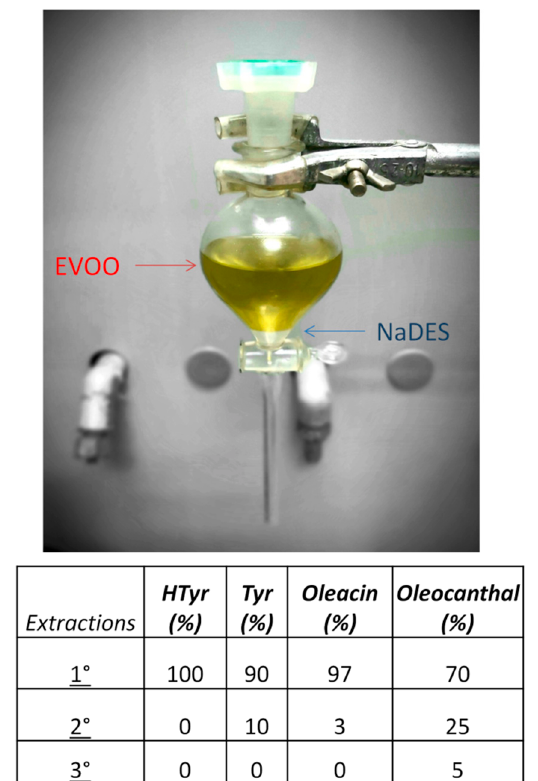
Figure 7. EVOO extraction with NaDES ( up ) and percentage recovery of the compounds after each extraction step ( bottom ) extraction step ( bottom ) .